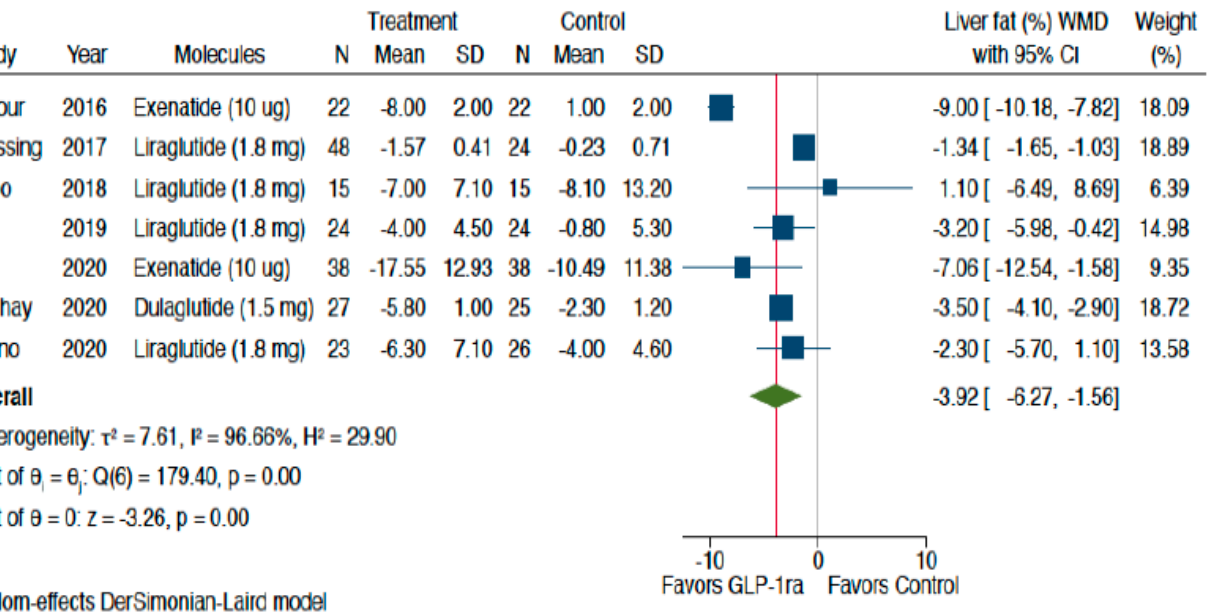
Figure 2. Forest plot and pooled estimates of the effect of different GLP-1 RAs on the absolute percentage of liver fat content as assessed by magnetic resonance-based techniques ( n = 7 RCTs included) as compared with placebo or reference therapy. The pooled (green diamond) and individual effect sizes for all RCTs included were expressed as weighted mean difference (WMD) and 95% confidence intervals (CI). The blue square in the figure represents the WMD for each single RCT.